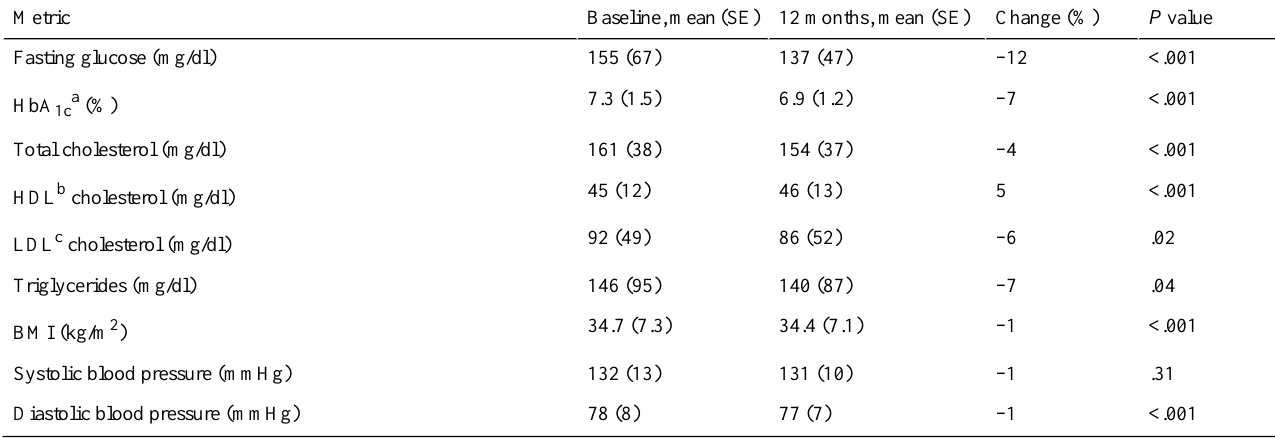
Table 2. Impact of digital medicine management at 12